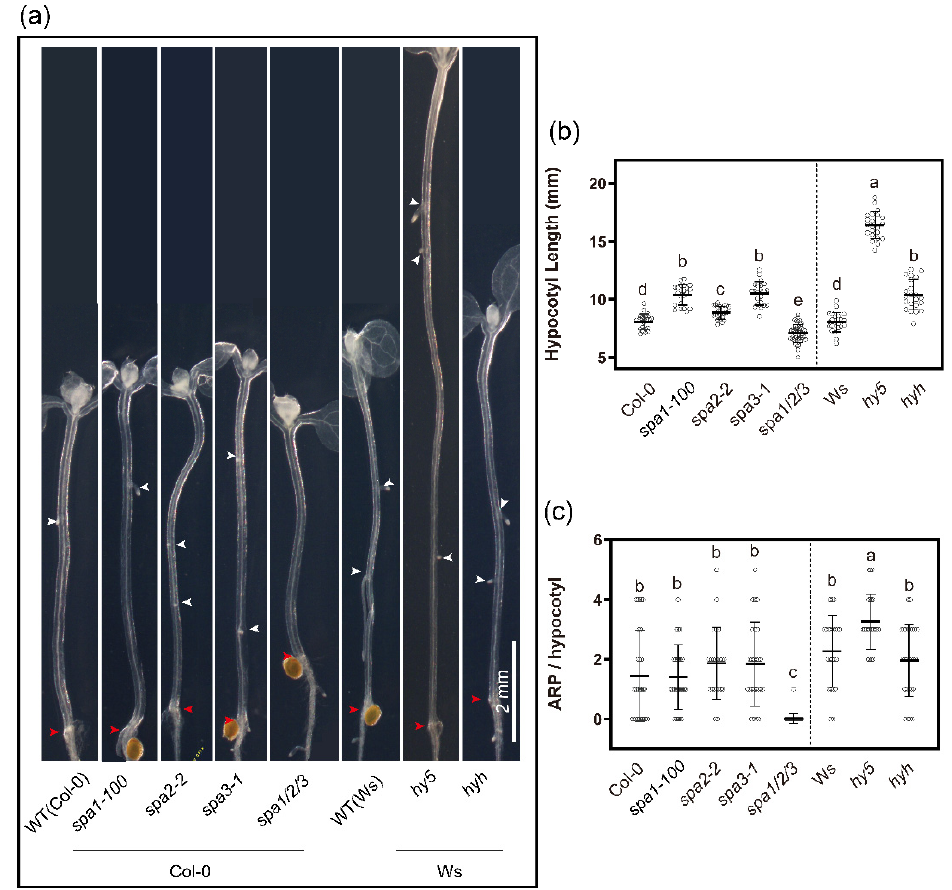
Figure 5. Hypocotyl elongation and adventitious root formation phenotypes of spa1,2,3 single and triple mutants, hy5 and hyh . ( a ) Representative images of WT (Col-0), spa1-100 (Col-0), spa2-2 (Col-0), spa3-1 (Col-0), spa1/2/3 triple (Col-0), WT (Ws), hy5 (Ws) and hyh (Ws) mutant cleared hypocotyl grown in the light for 4 days after 3 days etiolation. White arrowheads indicate ARPs, the red arrowhead points to the hypocotyl root junction. ( b , c ) Quantification of the ( b ) hypocotyl length and ( c ) ARP of the seedlings as in ( a ). The data in ( b , c ) are represented as mean values ± SD (Col-0, n = 27; spa1-100 , n = 25; spa2-2 , n = 22; spa3-1 , n = 25; spa1/2/3 triple n = 40; Ws, n = 22; hy5 n = 23 and hyh, n = 26). Different letters indicate a significant difference at p ≤ 0.05 (ANOVA and LSD post hoc analysis). Scale bar: 2 mm. All images were taken with the same